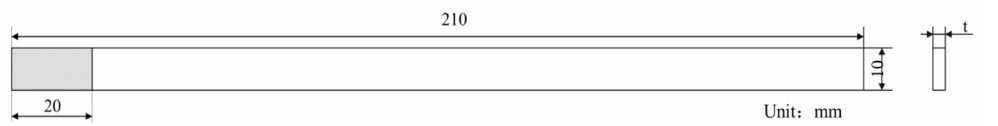
Figure 5. Schematic diagram of vibration model test system.